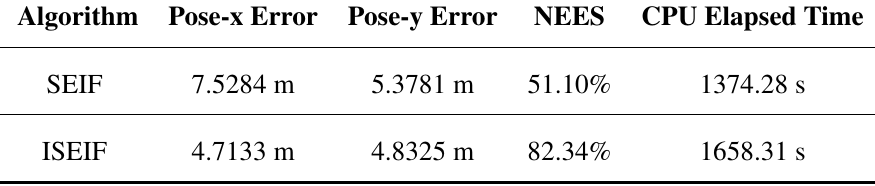
Table 3. Comparisons of the performances of SEIF and ISEIF for the Victoria Park dataset.